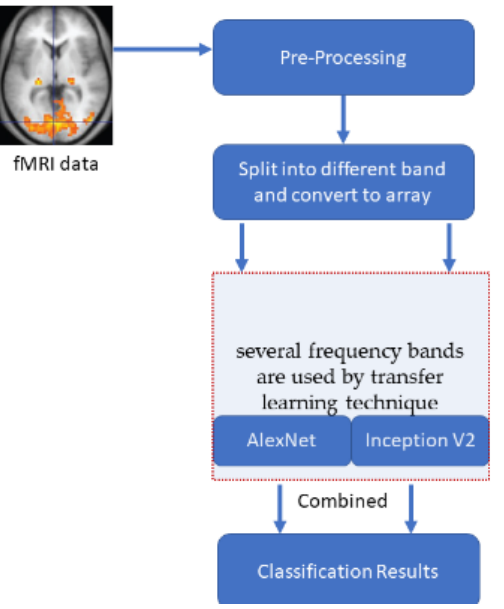
Figure 3. The overall process of the execution model.